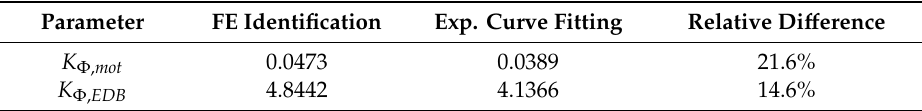
Table 2. EMF model parameter